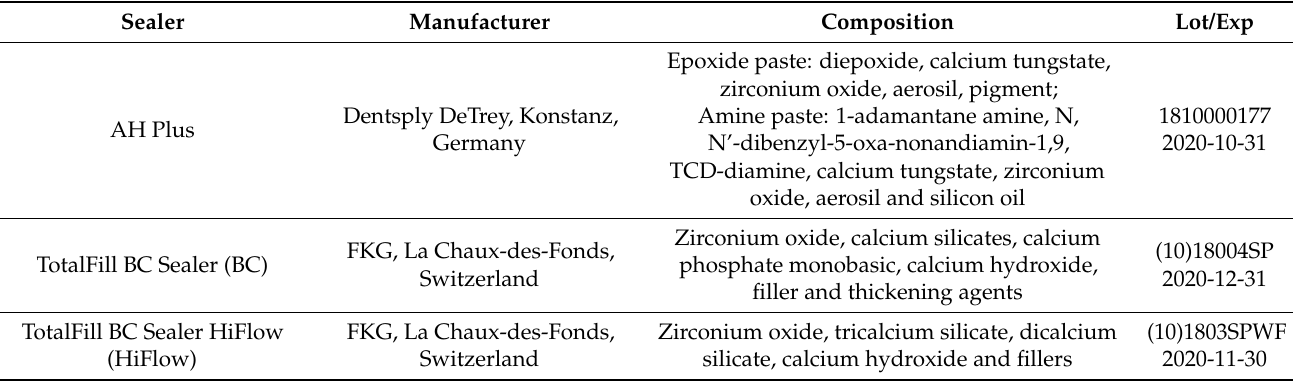
Table 1. Composition of the sealers according to the